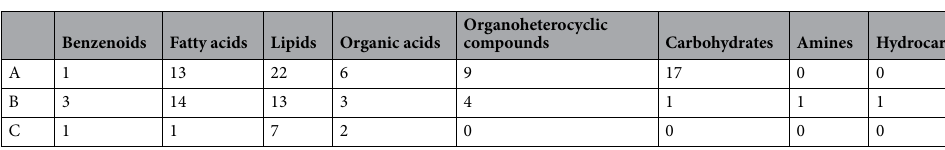
Table 2. Classification of